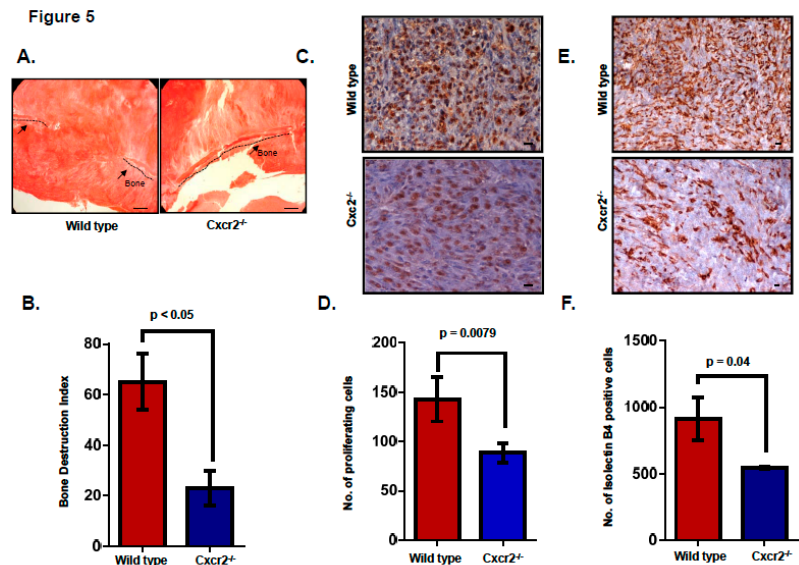
Figure 5. Host Cxcr2 deficiency reduced tumor-induced osteolysis. ( A ) Representative images show H&E staining demonstrating the intact cranial bone in Cxcr2 − / − mice in comparison with severe bone destruction in wild type mice. Scale bar represents 100 µ m ( B ) Bar graph shows significantly lower bone destruction index in Cxcr2 − / − mice in comparison with wild type mice ( n = 5, p < 0.05). ( C ) Representative images show immunohistochemical staining for PCNA cells demonstrating higher cell proliferating cells in the tumor of the wild type mice in comparison with the Cxcr2 − / − mice. Scale bar represents 10 µ m. ( D ) Bar graph demonstrates a lower number of proliferating cells in Cxcr2 − / − mice in comparison with wild type mice ( n = 5, p = 0.0079). ( E ) Representative images show immunohistochemical staining for isolectin B4 positive cells demonstrating higher microvessel density in the tumor of the wild type mice in comparison with the Cxcr2 − / − mice. Scale bar represents 10 µ m. ( F ) Bar graph demonstrates lower microvessel density at the tumor-bone interface in Cxcr2 − / − mice in comparison with wild type mice. ( n = 5, p = 0.04).